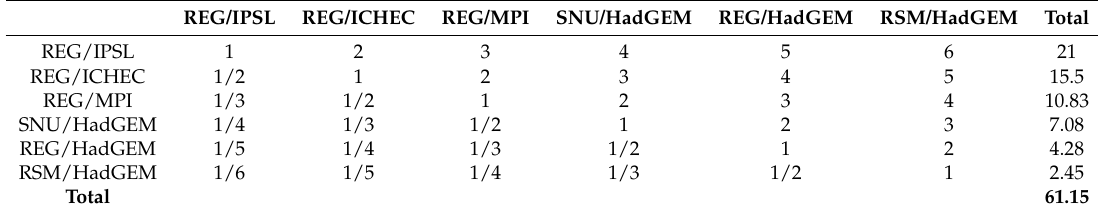
Table 4. A reciprocal matrix between sets of